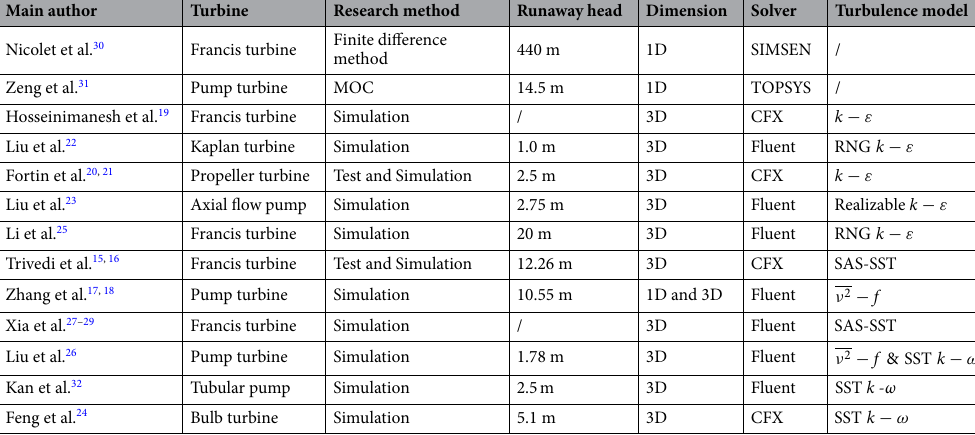
Table 1. Recapitulation of parameter description of runaway